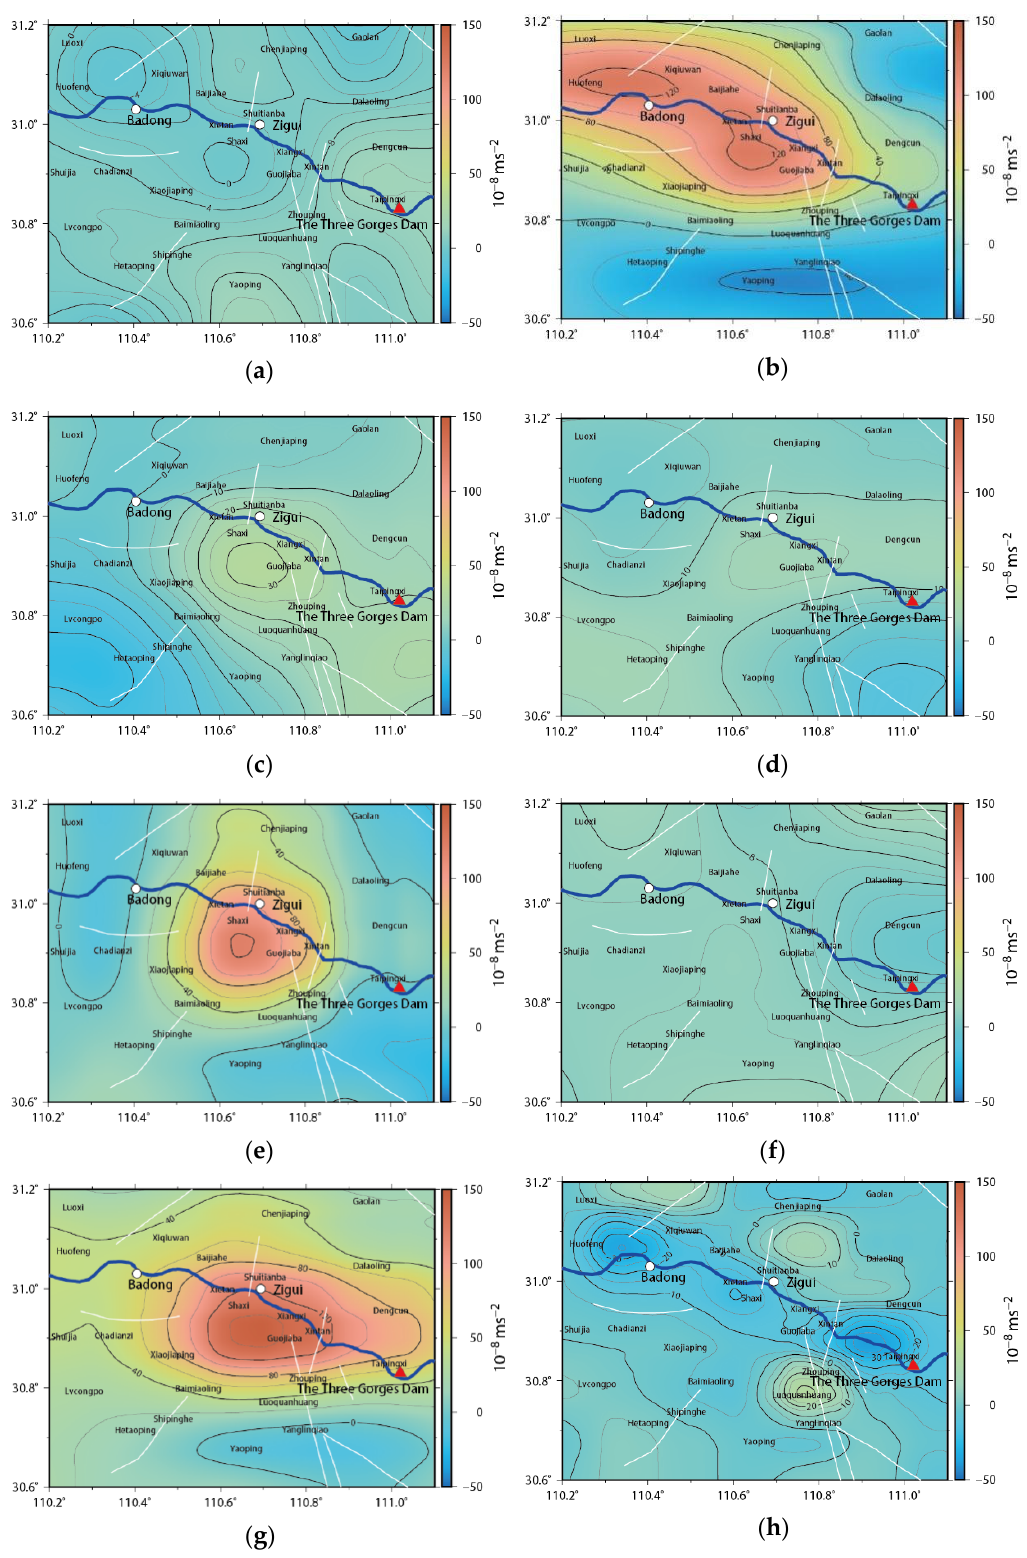
Figure 6. Gravity field differential dynamic variation images in the study area during the impound- ment of the Three Gorges Project (October 2001–October 2009). ( a ) October 2001–October 2002; ( b ) October 2002–October 2003; ( c ) October 2003–November 2004; ( d ) November 2004–October 2005; ( e ) October 2005–November 2006; ( f ) November 2006–November 2007; ( g ) November 2007–November 2008; ( h ) November 2008–October 2009. Table 2. Average monthly earthquake frequency in different magnitude grades of the study area and in different impoundment stages of TGR.